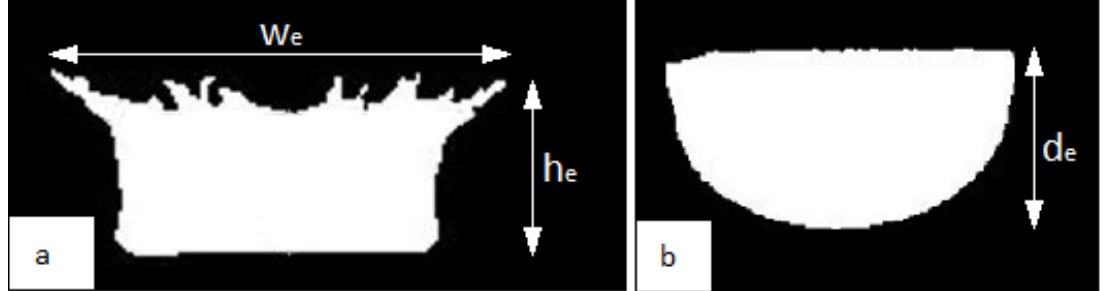
Figure 1. Size parameters of the experimental crown ( a ): h e —crown height, w e —external width of the crown. Size parameter of the experimental cavity ( b ): d e —depth of the cavity. Index “e” specifies the results from the